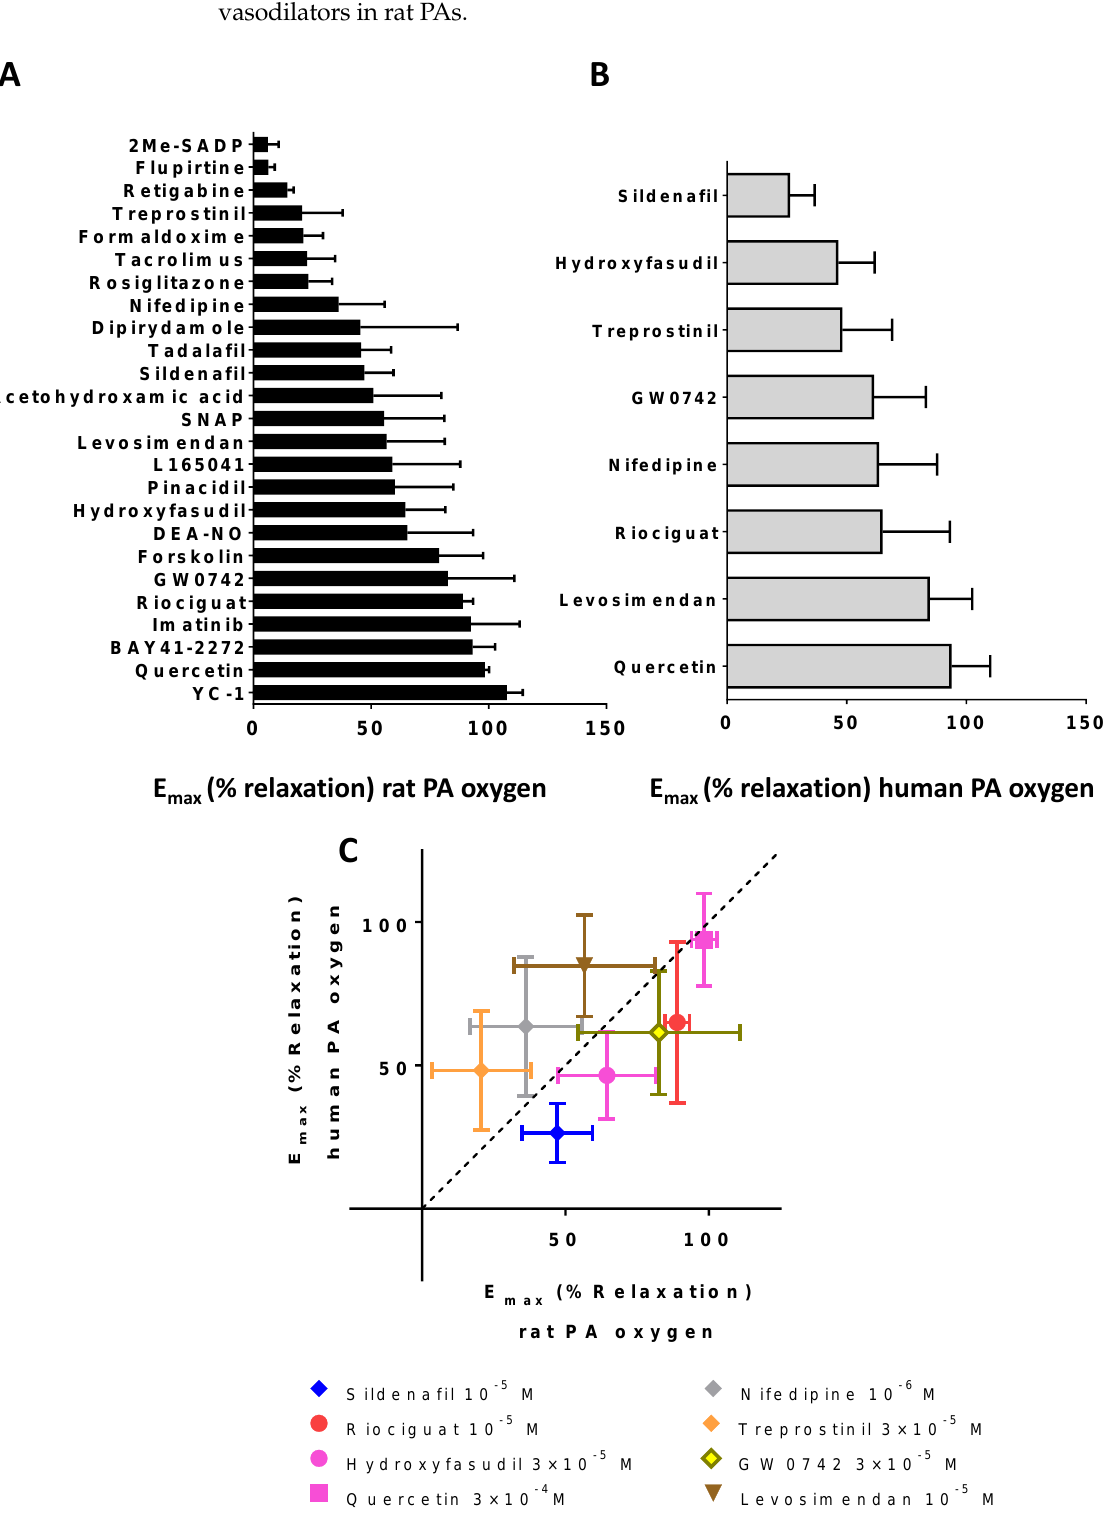
Figure 1. Efficacy of vasodilators. Bar graph representing the percent of maximal relaxation (E max ) of several vasodilator drugs on contractile tone in rat PA arteries ( A ) and human PA ( B ) bubbled with 95% O 2 -5% CO 2 (PA oxygen). Comparison of the E max effects of several drugs in rat and human PA ( C ). Abscissa, vasodilation of rat PA (E max (% relaxation)); ordinate, vasodilation on human PA (E max (% relaxation)). Calculated from data in Figures S1–S8. Data are means ±